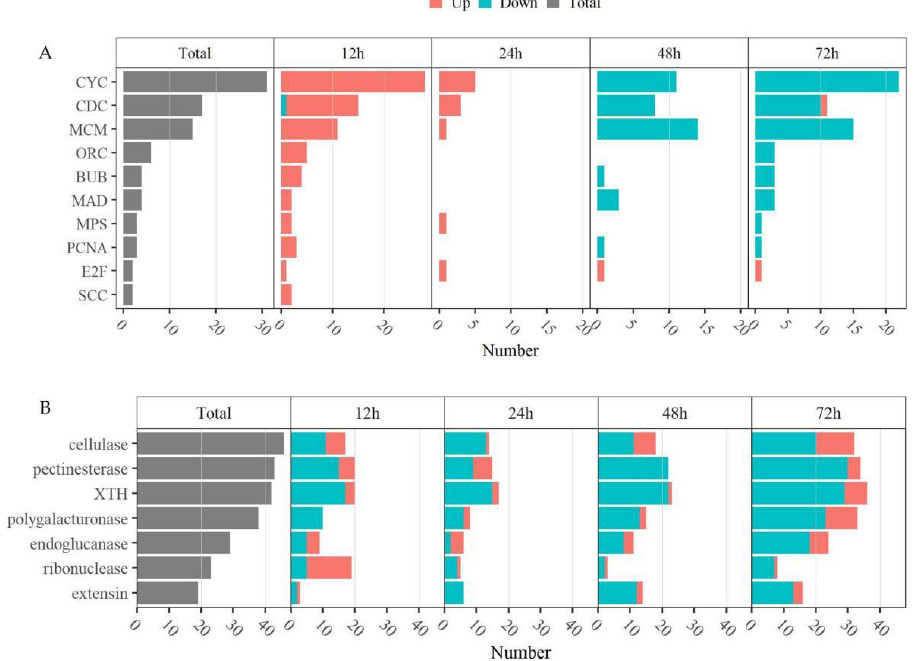
Figure 11. TDZ regulates the gene expression of the cell cycle ( A ) and cell wall ( B ) in AZ. DEGs were determined between 12 h and 0 h, 24 h and 0 h, 48 h and 0 h, 72 h and 0 h, respectively. The DEGs were controlled by FDR<5% and |log2Fc|≥1.